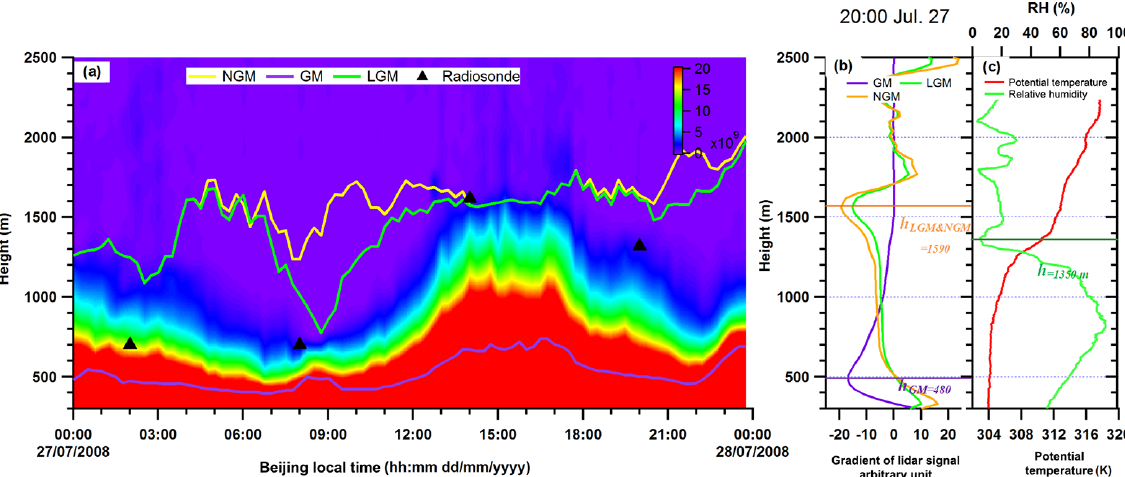
Figure 2. (a) Evolution of the lidar range-squared-corrected signal (RSCS) at 532nm on 27 July. The color scale indicates the intensity of the RSCS, and warm colors represent stronger light scattering. The diurnal BLH retrieved by LGM, GM, and NGM are illustrated as green, purple, and yellow lines, respectively. Black triangles show the BLH retrieved by radiosonde. (b) The profiles of LGM, GM, and NGM, and the corresponding retrieval BLH at 20:00 on 27 July. LGM, GM, and NGM are illustrated as green, purple, and yellow lines, respectively. (c) Potential temperature and relative humidity at 20:00 on 27